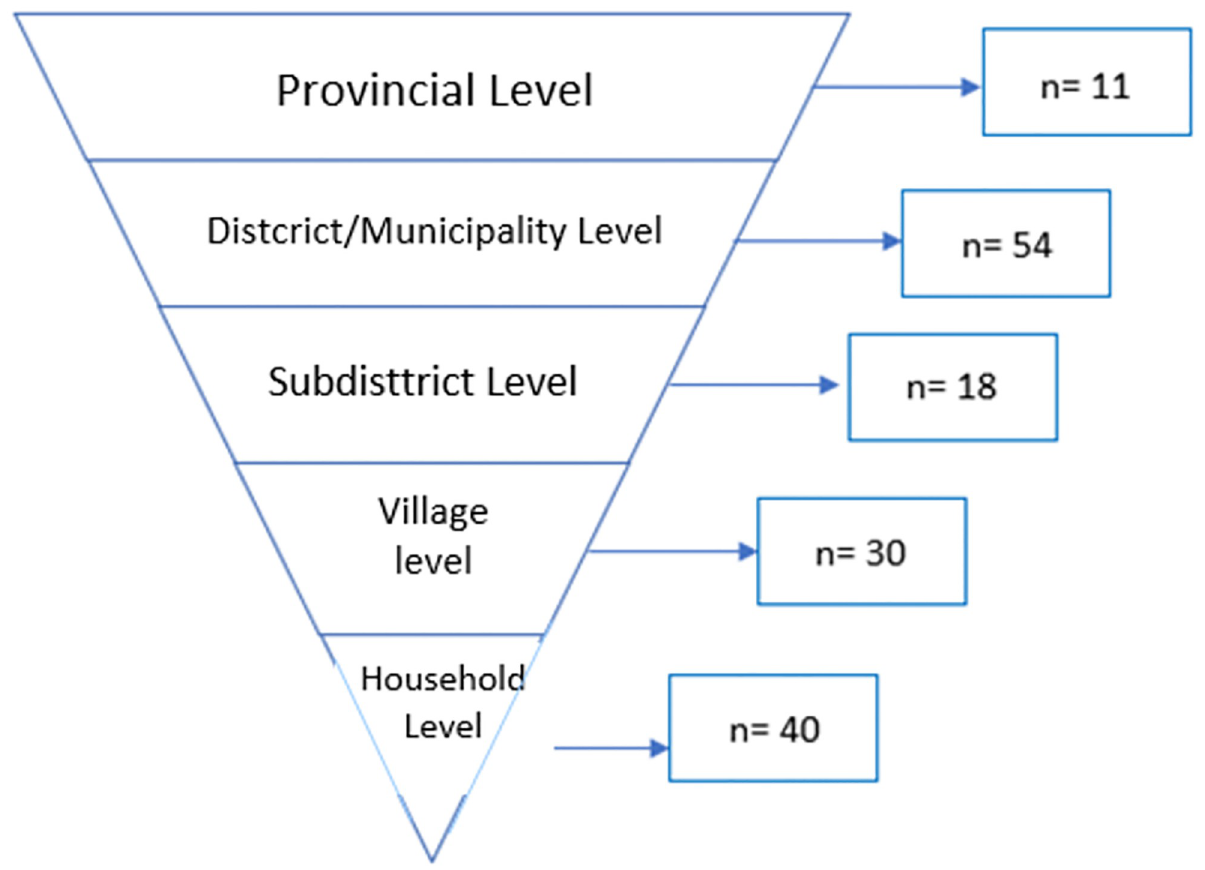
Fig 2. Diagram of levels of informant